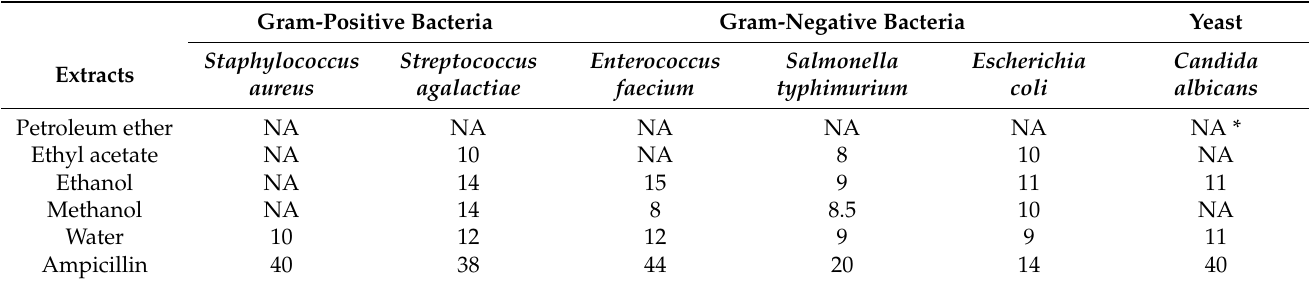
Table 8. Antimicrobial activity (expressed as the diameter of zone of inhibition) of different extracts of A. iva leaves ( n = 3 samples, 3 replicates per